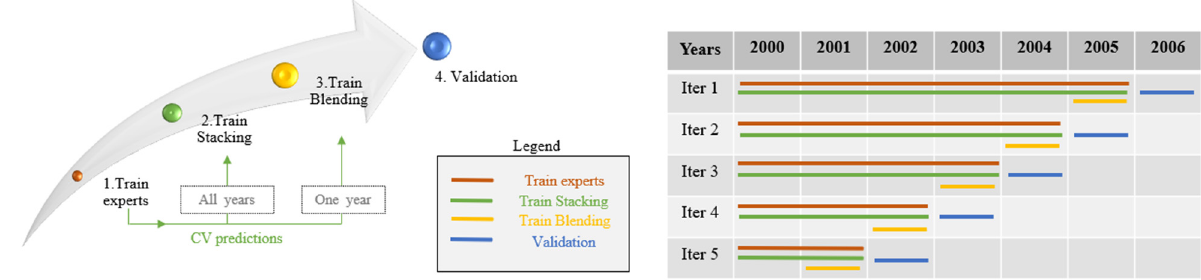
Figure 5. Test II. The arrow on the left indicates the training flow: experts, Stacking, Blending and validation. The table placed on the right points out the years used to train and validate each model.